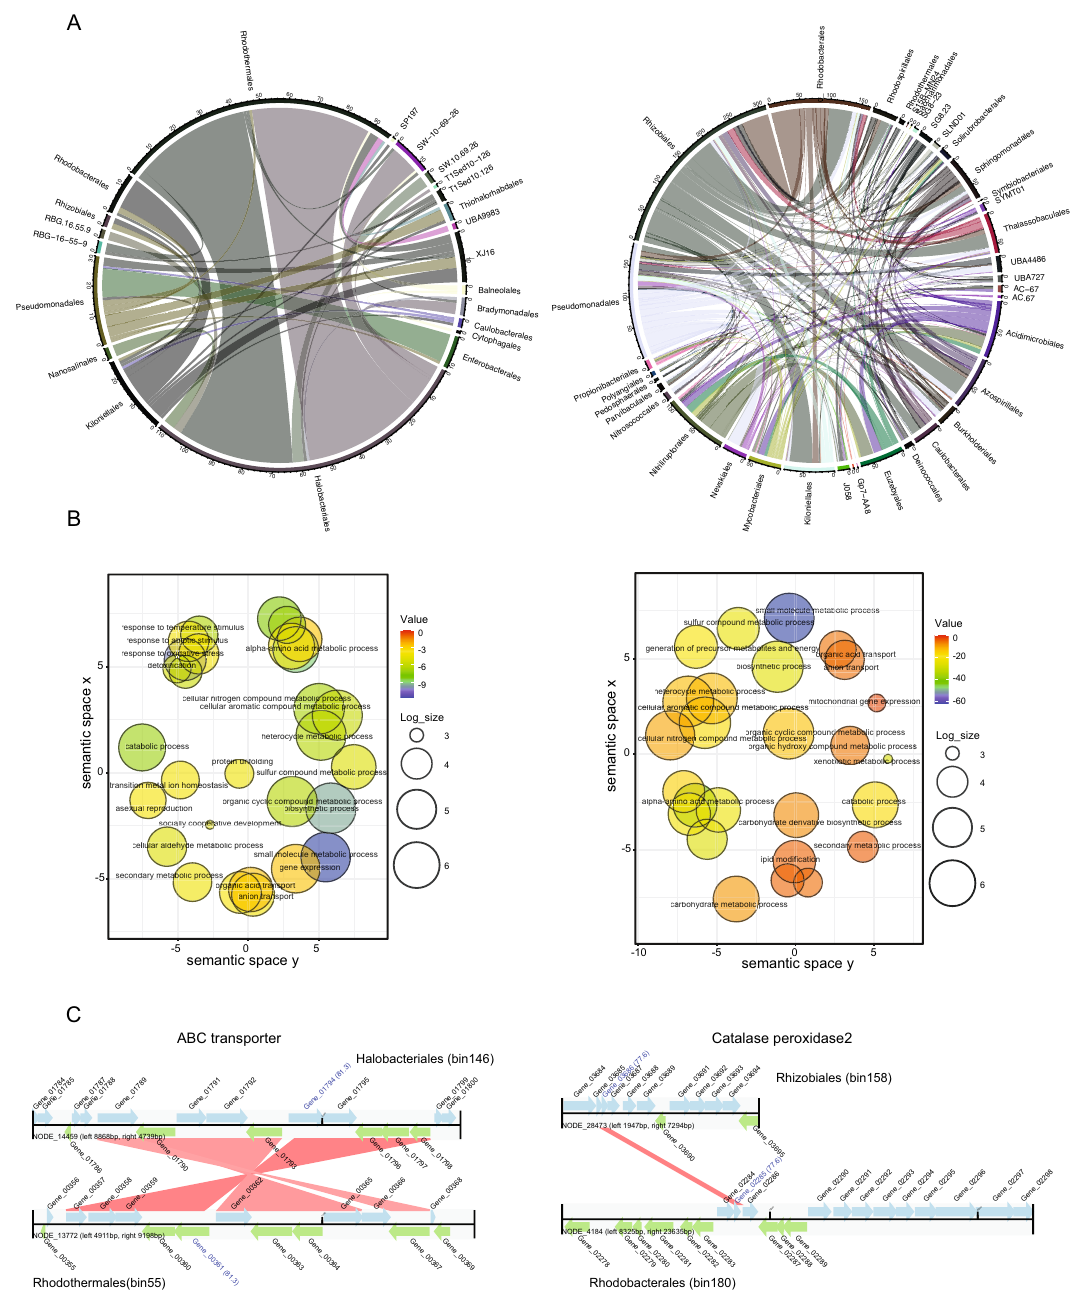
Figure 6. Horizontal gene transfer at the taxonomic order level for inner and outer sabkha. ( A ) MetaChip summary Circos plot of horizontal gene transfer (HGT) at the order level for inner (left panel) and outer (right panel). The thickness of the connecting band represents that more transfer is happening between these groups. ( B ) PFAM enrichment analysis for inner (left panel) and outer (right panel) using dcGO. The results are plotted as a sematic space scatter plot by the logarithmic p value represented by a color bar chart and logarithm size of the PFAM numbers. ( C ) Example of inner (left panel) HGT between Halobacteriales and Rhodothermales for ABC transporter, and outer (right panel) for a Catalase peroxidase2 between Rhizobiales and Rhodobacteriales